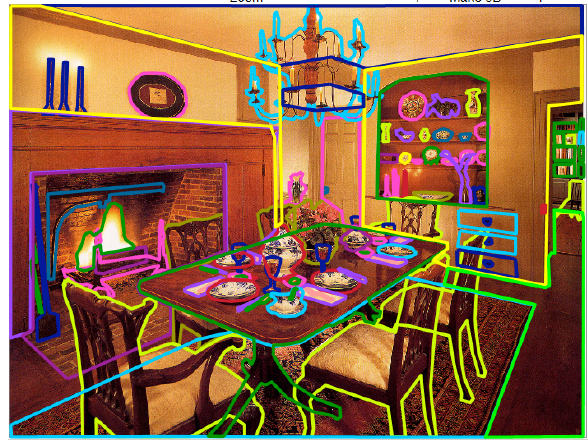
Figure 1. A dining room scene from the LabelMe data-